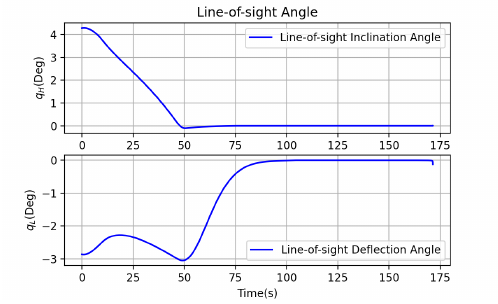
Figure 13. Line-of-sight angle (target